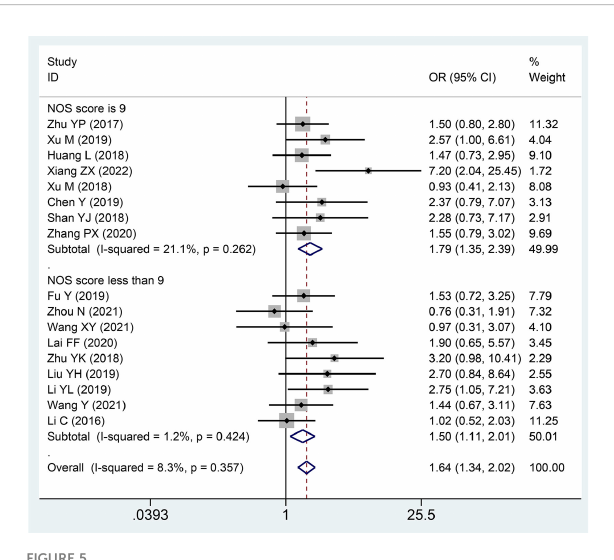
FIGURE 5 Forest plot showing the relationship between small nucleolar RNA host gene (SNHG) expression and lymph node metastasis (LNM) stage in colorectal cancers.